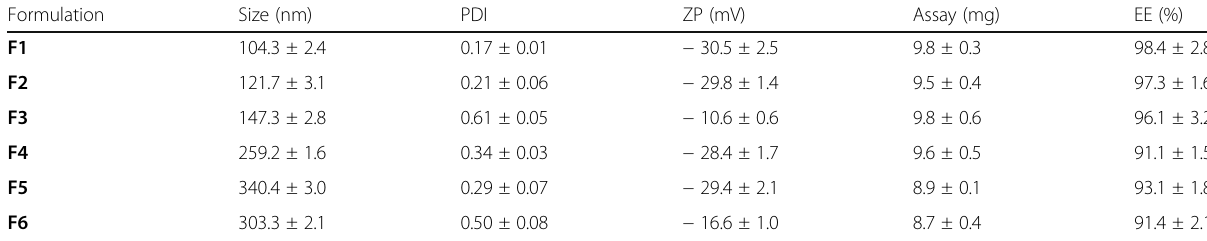
Table 2 Physicochemical characteristics — size, PDI, zeta potential, entrapment efficiency, and assay of zotepine loaded solid lipid nanoparticle formulations (mean ± SD, n = 3)